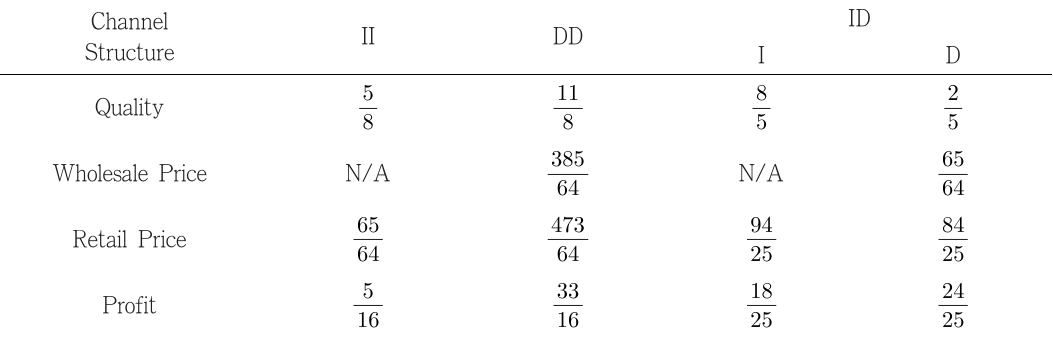
<Table 4> Outcomes of Retail Prices, Wholesale Prices, and Suppliers’ Profits (when market is not covered,     